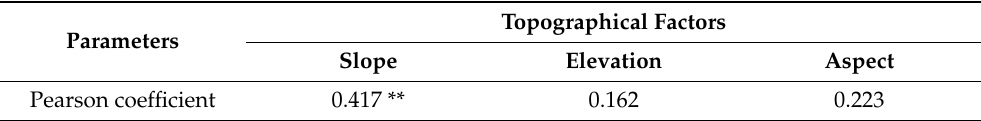
Table 5. Topographical factors—AGB correlation